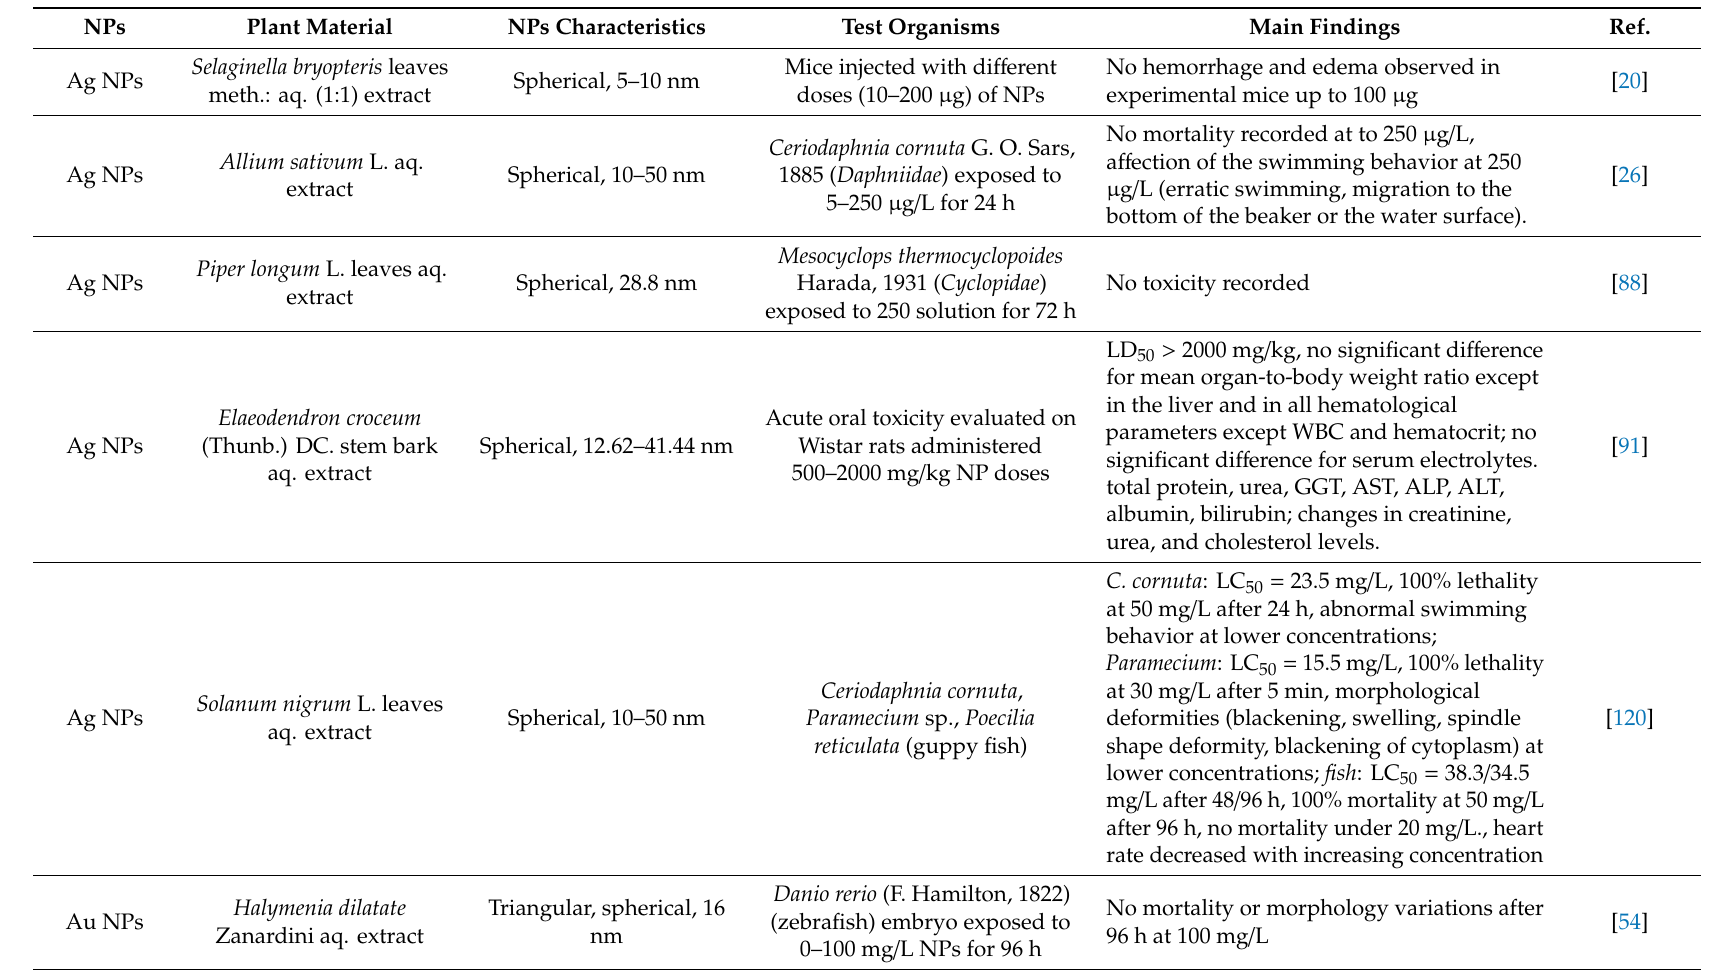
Table 6. Toxicological studies regarding phytosynthesized nanoparticles (as presented in studies published in